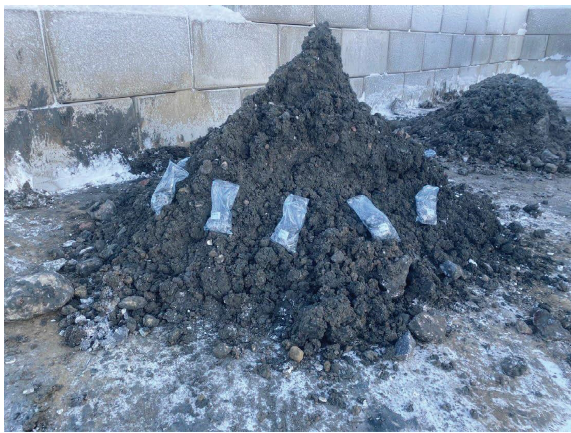
Figure 5: Second phase sampling